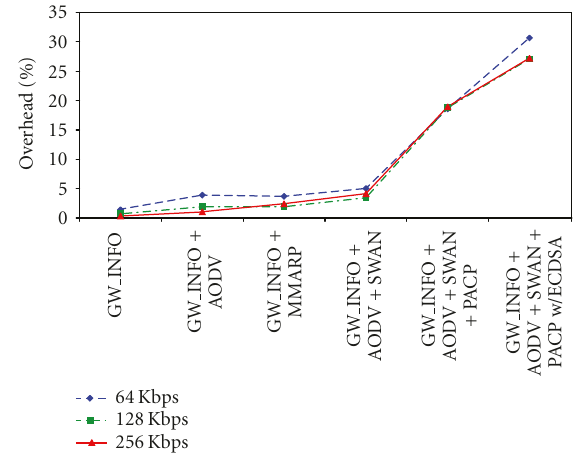
Figure 12: Cumulative overhead with the increase of functionali-